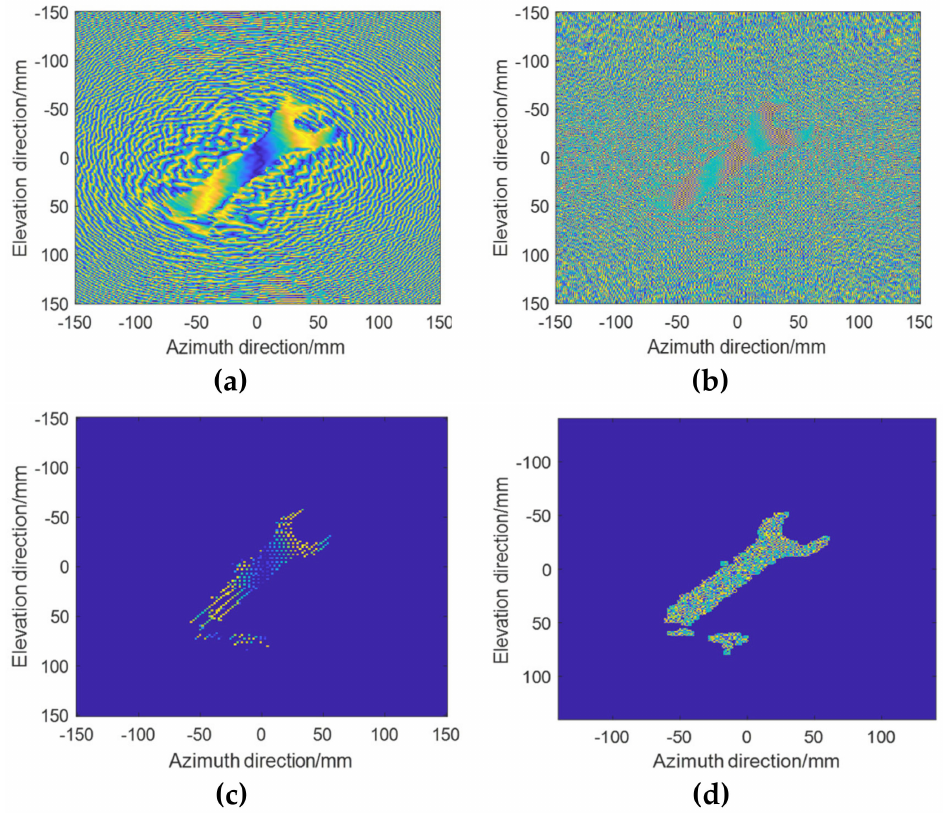
Figure 9. Imaging results of phase. ( a ) The imaging result of phase when using BPA. ( b ) The imaging result of phase when using NUFFT-RMA. ( c ) The imaging result of phase when using OMP. ( d ) The imaging result of phase when using the proposed